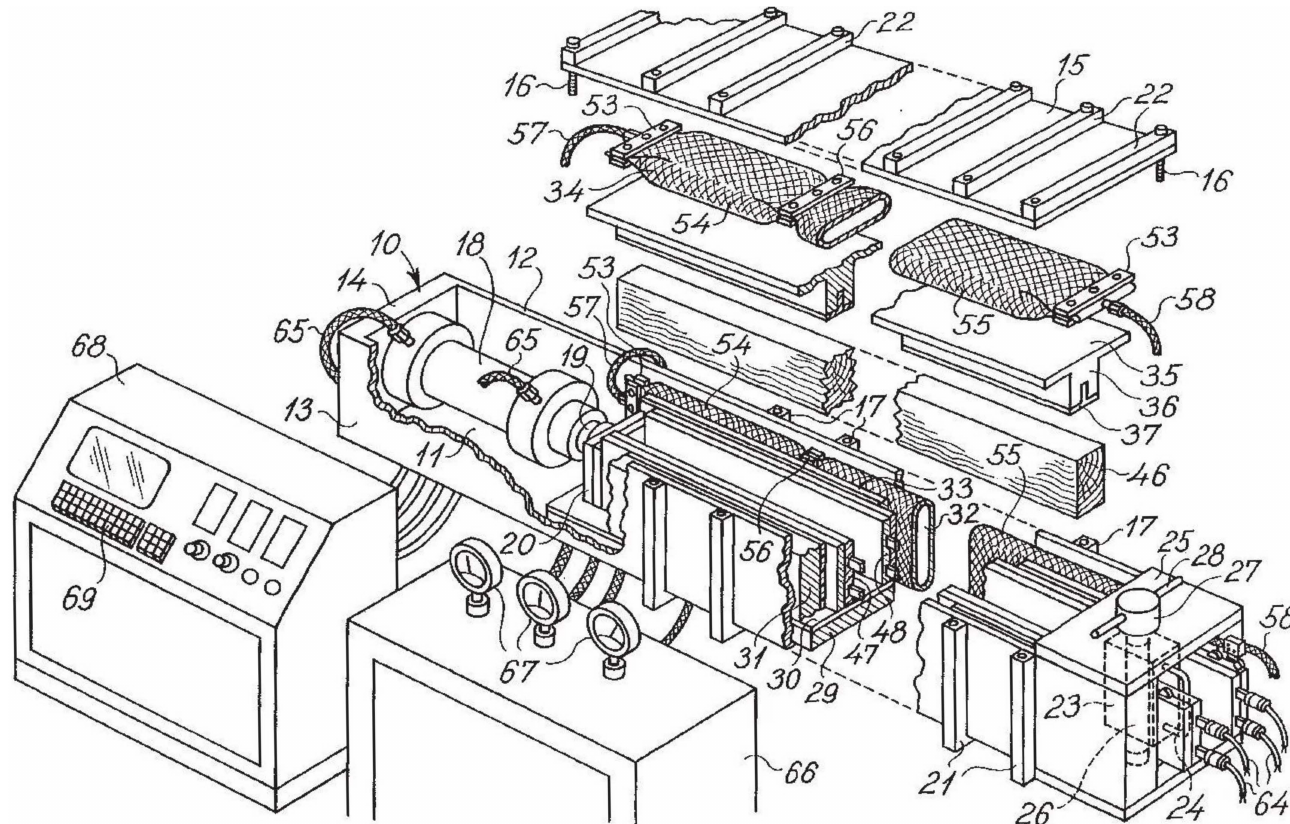
Figure 5. Theoretical scheme of a compressing machine. Reproduced from